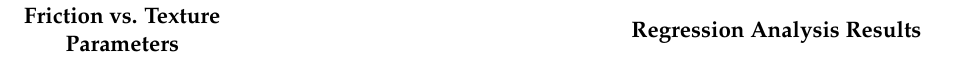
Table 8. Regression analysis of friction vs. texture